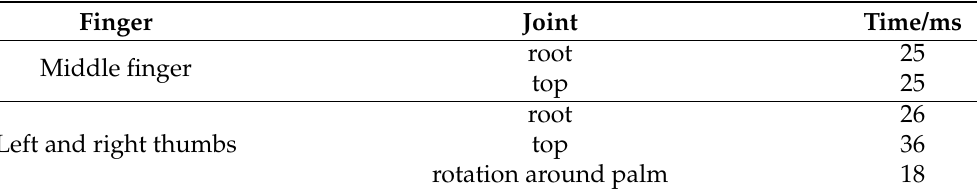
10% of the reference ±